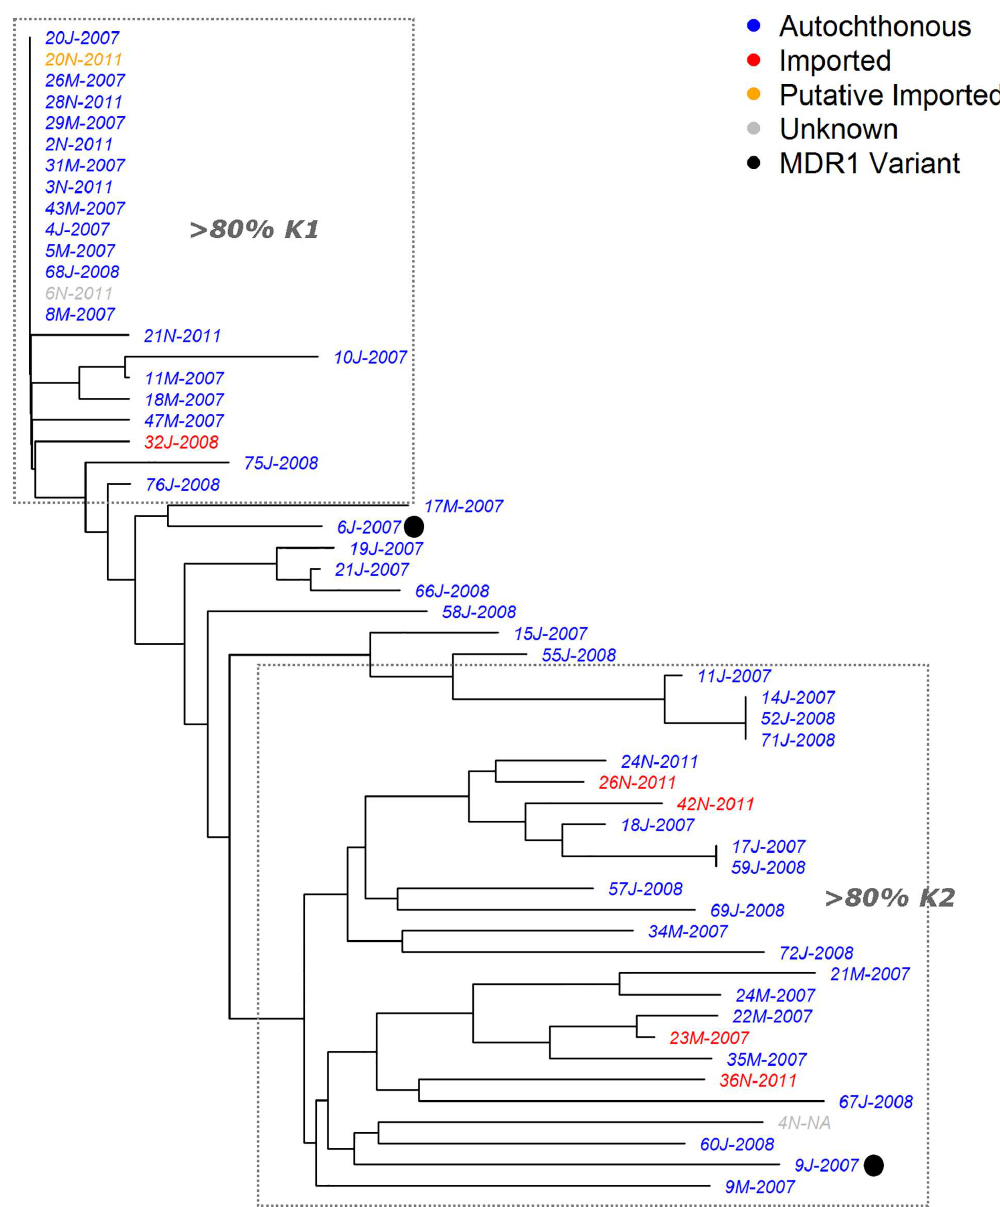
Fig 2. Neighbour-joining tree illustrating the genetic relatedness between the P . vivax isolates across 9 loci. Only isolates with completegenotyping data across all 9 loci are presented. The two isolates highlightedwith black dots, 6J and 9J, exhibiteddiffering pvmdr1 multi-locus genotypes from the other isolates: L953-Y976-N1010- F0176 in 6J and 9J versus L953-Y976-N1010-L1076 in the other isolates. The dotted grey outlines illustrate the isolates with high ancestry to K 1 and K 2 at K =